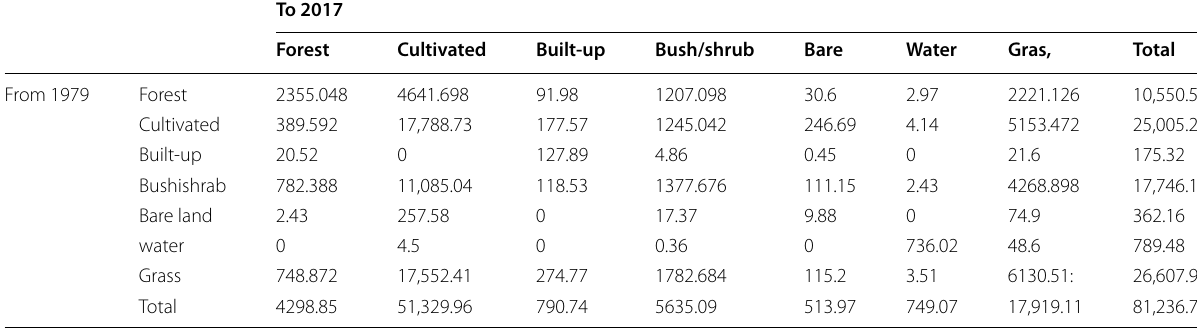
Table 6 Matrix for land use and land cover changes for 1979 to 2017 in Hectares (ha) To 2017 Forest Cultivated Built-up Bush/shrub From 1979